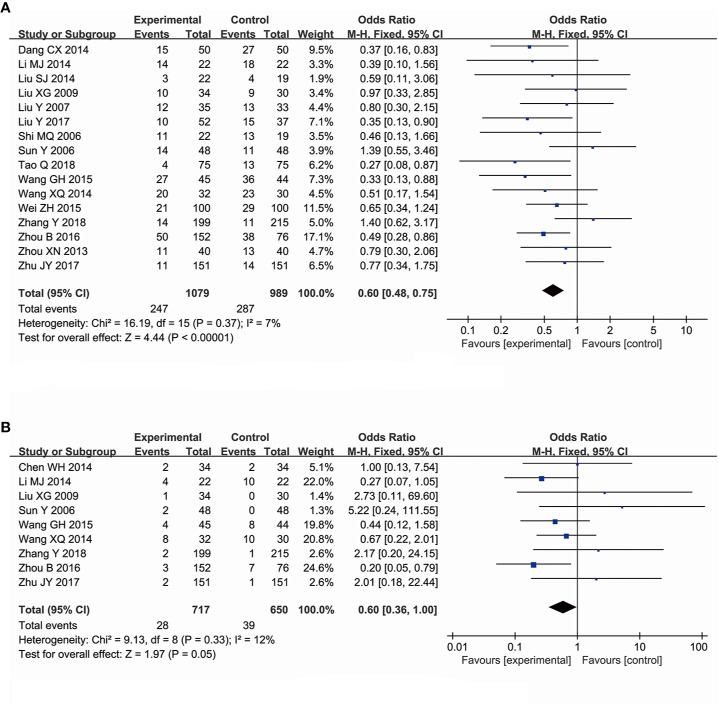
Forest plot for the decline of platelet counts. (A) The decline of platelet counts I–IV. (B) The decline of platelet counts III–IV.